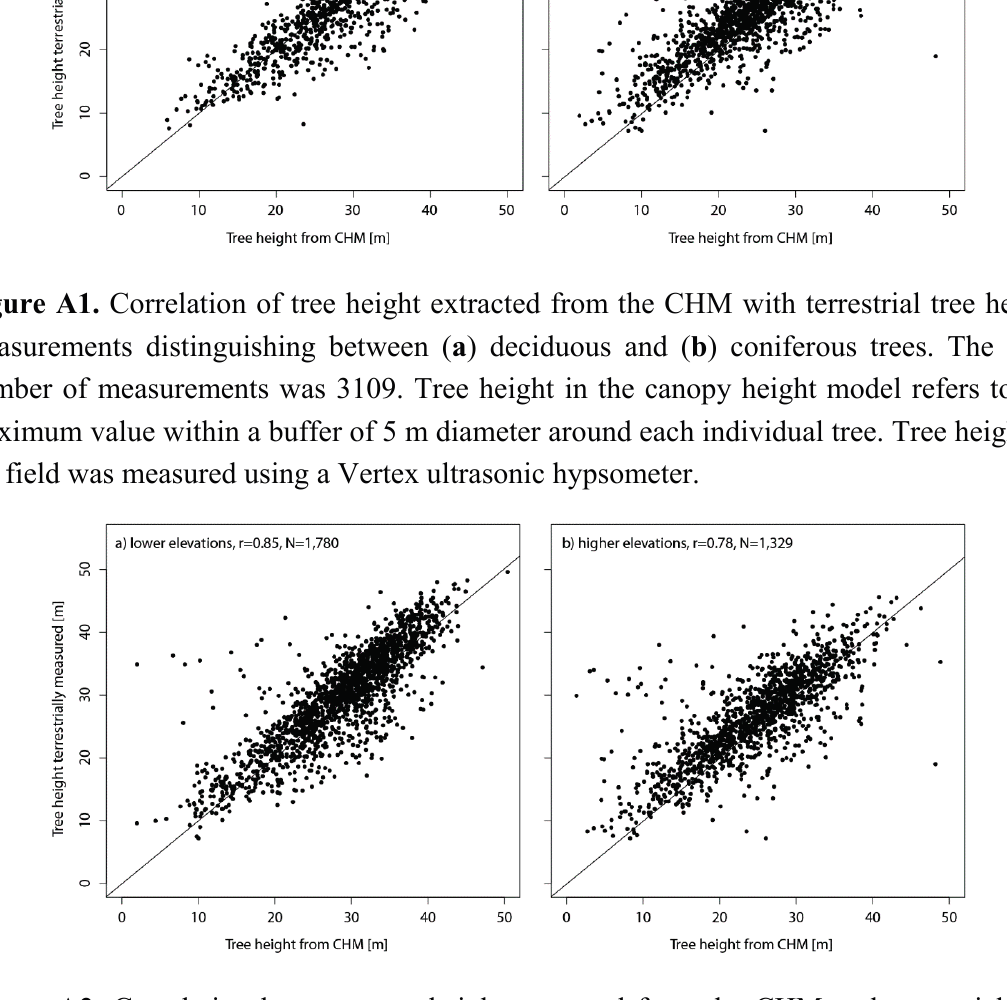
Figure A2. Correlation between tree height extracted from the CHM and terrestrial tree height measurements distinguishing between ( a ) lower and ( b ) higher elevations. Total number of measurements was 3109. Tree height in the canopy height model refers to the maximum value within a buffer of 5 m diameter around each individual tree. Tree height in the field was measured using a Vertex ultrasonic